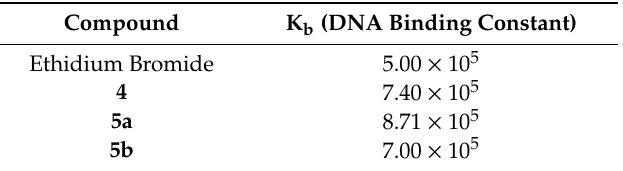
Table 1. DNA binding affinities toward ct-DNA determined via different methods.